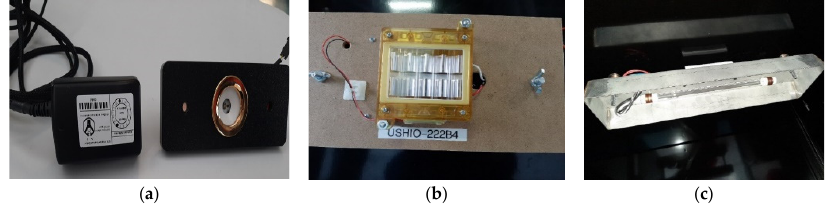
Figure 1. The light sources used in the study: ( a ) DIEHL 405 nm LED; ( b ) Ushio Excimer Lamp; ( c ) low-pressure mercury Bulb. All light sources were calibrated and certified by the manufacturers for peak wavelength emission. Appl. Sci. 2023 , 13 , x FOR PEER REVIEW